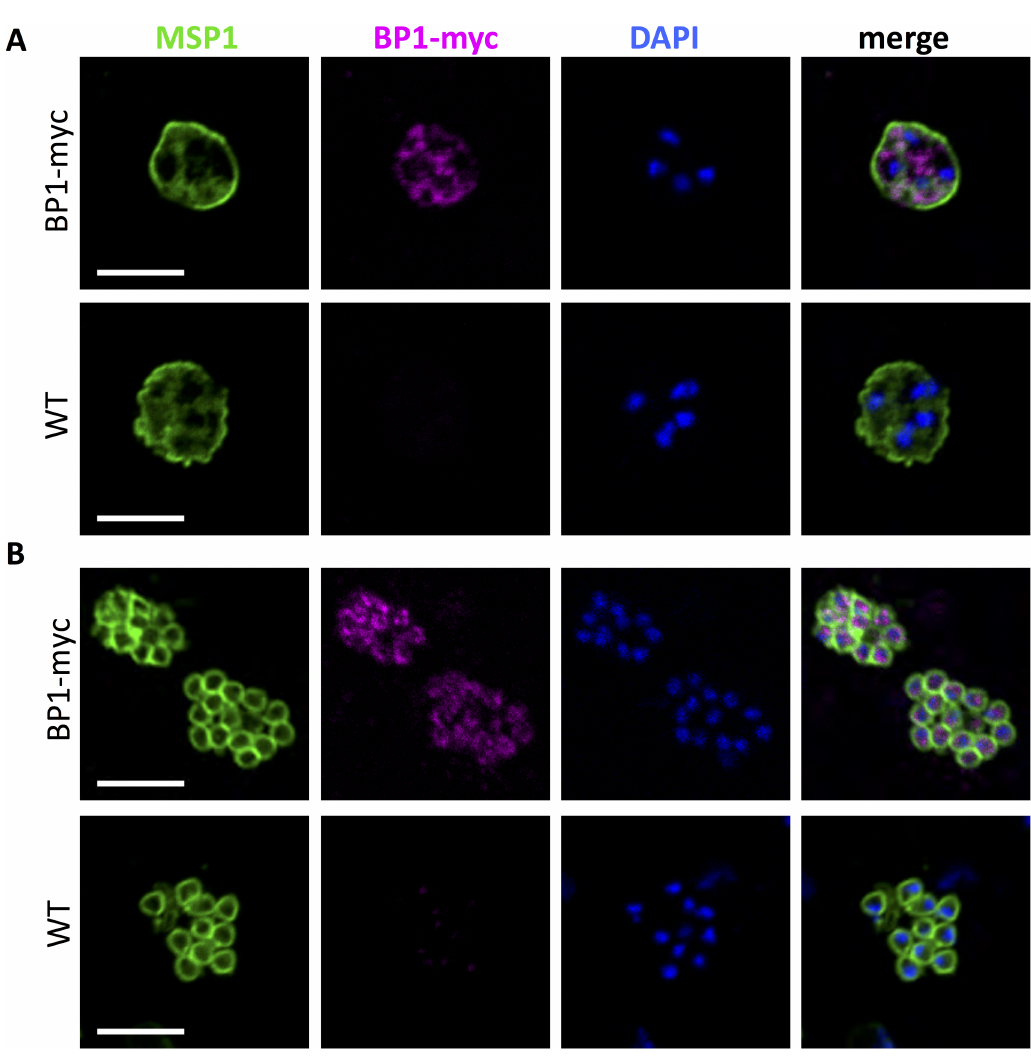
berghepain-1-myc, and anti-MSP1 (green) to visualizethe merozoitemembrane. Parasite DNA was stained with DAPI (blue). Scale bars: 5 μ m.